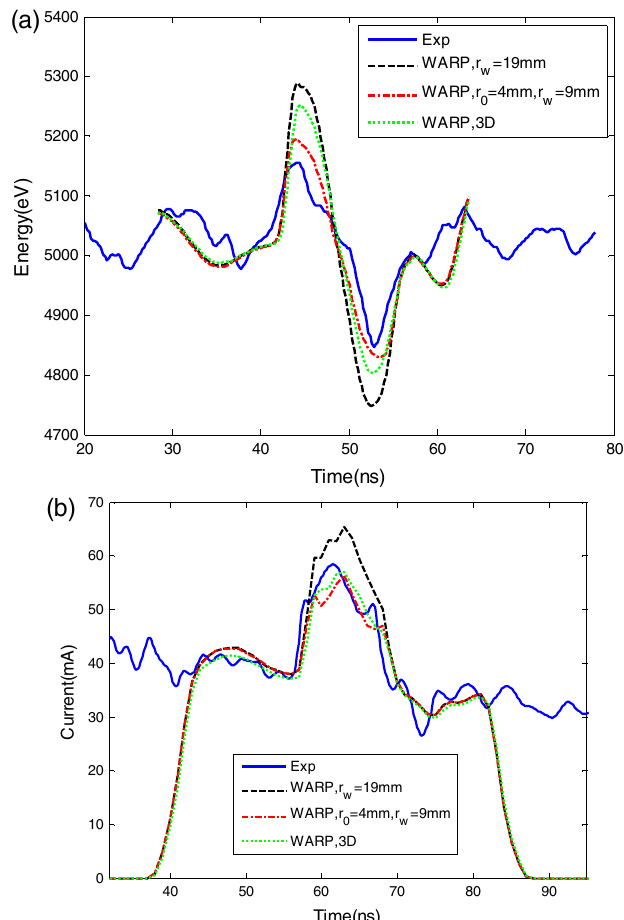
FIG. 12. (Color) Comparison of results from the experiment (blue solid lines), WARP simulations with 19 mm virtual tube (black dashed lines), WARP simulations with the 9 mm virtual tube and the initial beam radius of 4 mm (red dash-dotted lines), and WARP 3D simulations (green dotted lines): (a) mean energy profiles at LC2; (b) current profiles at